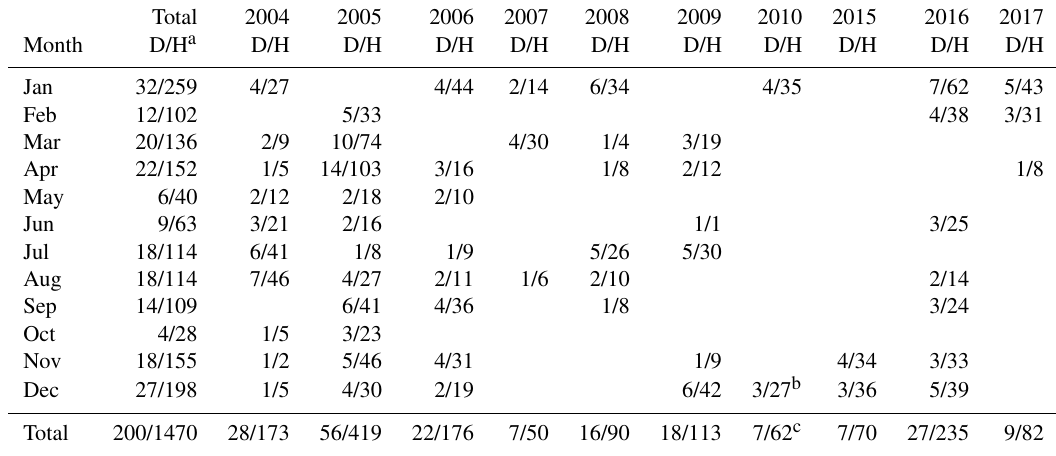
Table 1. Arecibo K lidar temperature data used in this study (days and hours, denoted by D/H) by month.